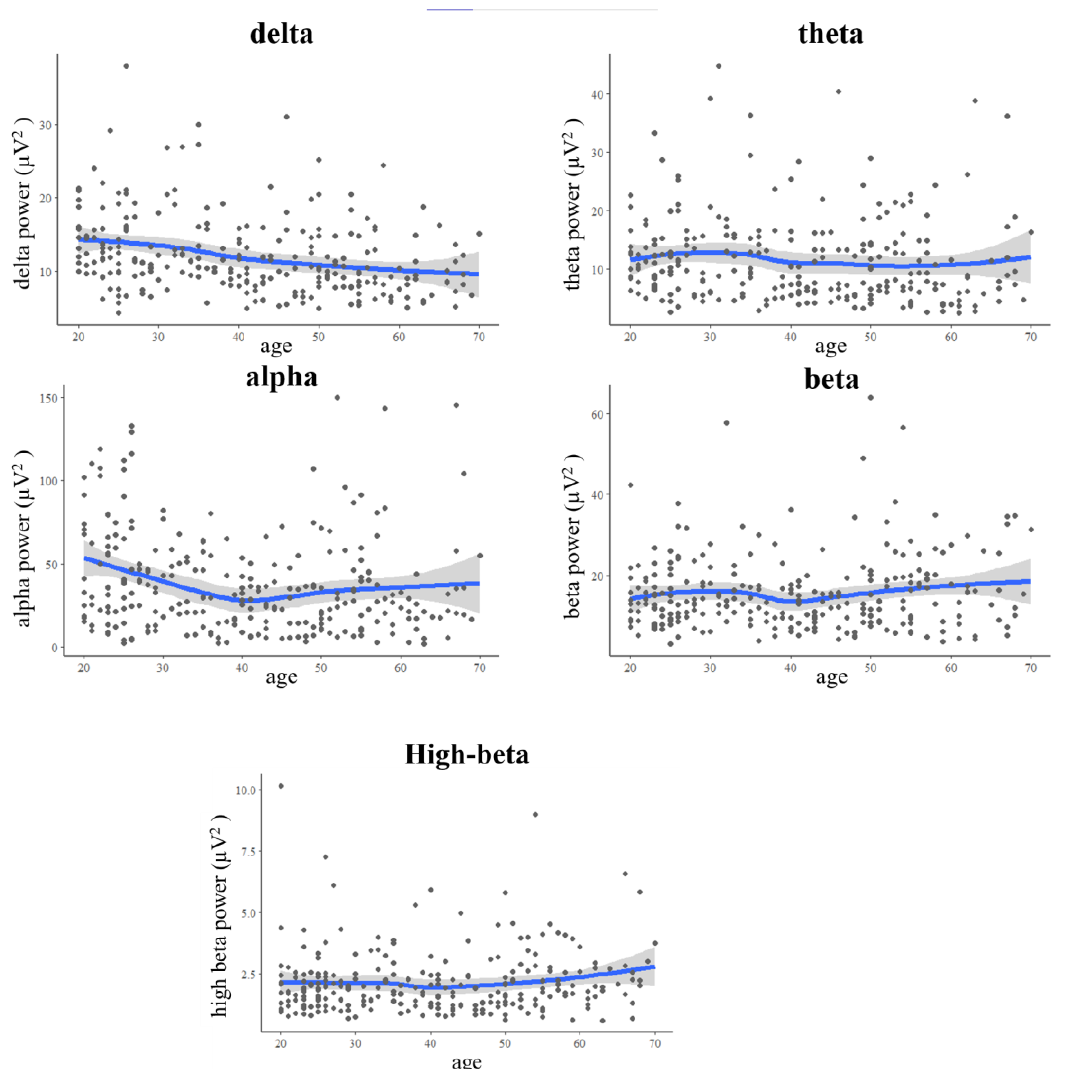
Figure 2. The EEG absolute power across different age groups. Note: The blue lines are locally weighted scatterplot smoothing of EEG absolute power. The gray areas are 95% of the confidence interval for EEG absolute power. The black dots are scatterplots of EEG absolute power for each participant.